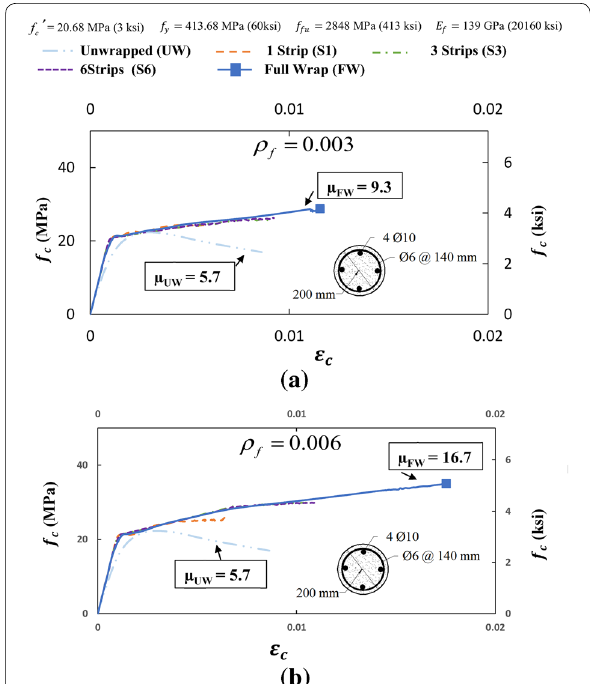
A cover = A g − A core Fig. 7 Comparison of compressive stress ( f c ) versus axial strain (ε c )